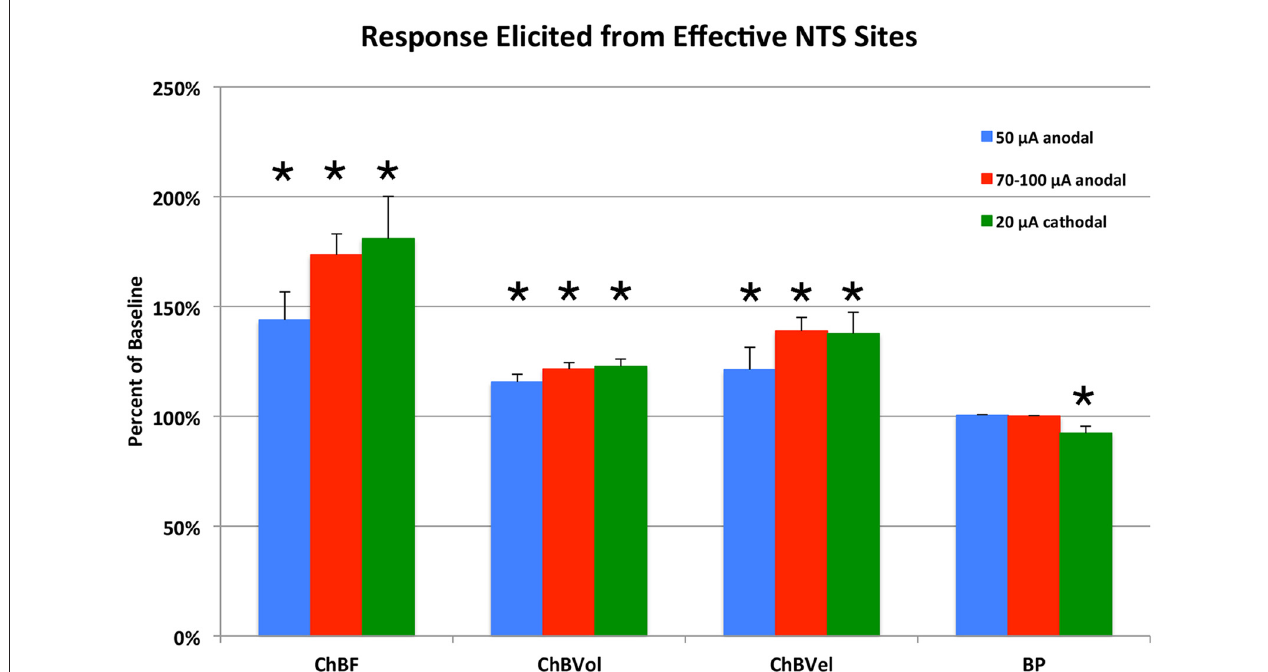
FIGURE 4 | Histogram showing the mean ChBF, ChBVol, ChBVel, and ABP responses to NTS stimulation at effective 50 µ A anodal, 70–100 µ A anodal, and 20 µ A cathodal NTS stimulation sites, expressed as a percent of basal ChBF, ChBVol and ChBVel responses and ABP. ChBF, ChBVol and ChBVel were significantly increased, but ABP was not at these sites. Asterisks indicate significantly different from baseline (100%). Error bars represent the SEM.